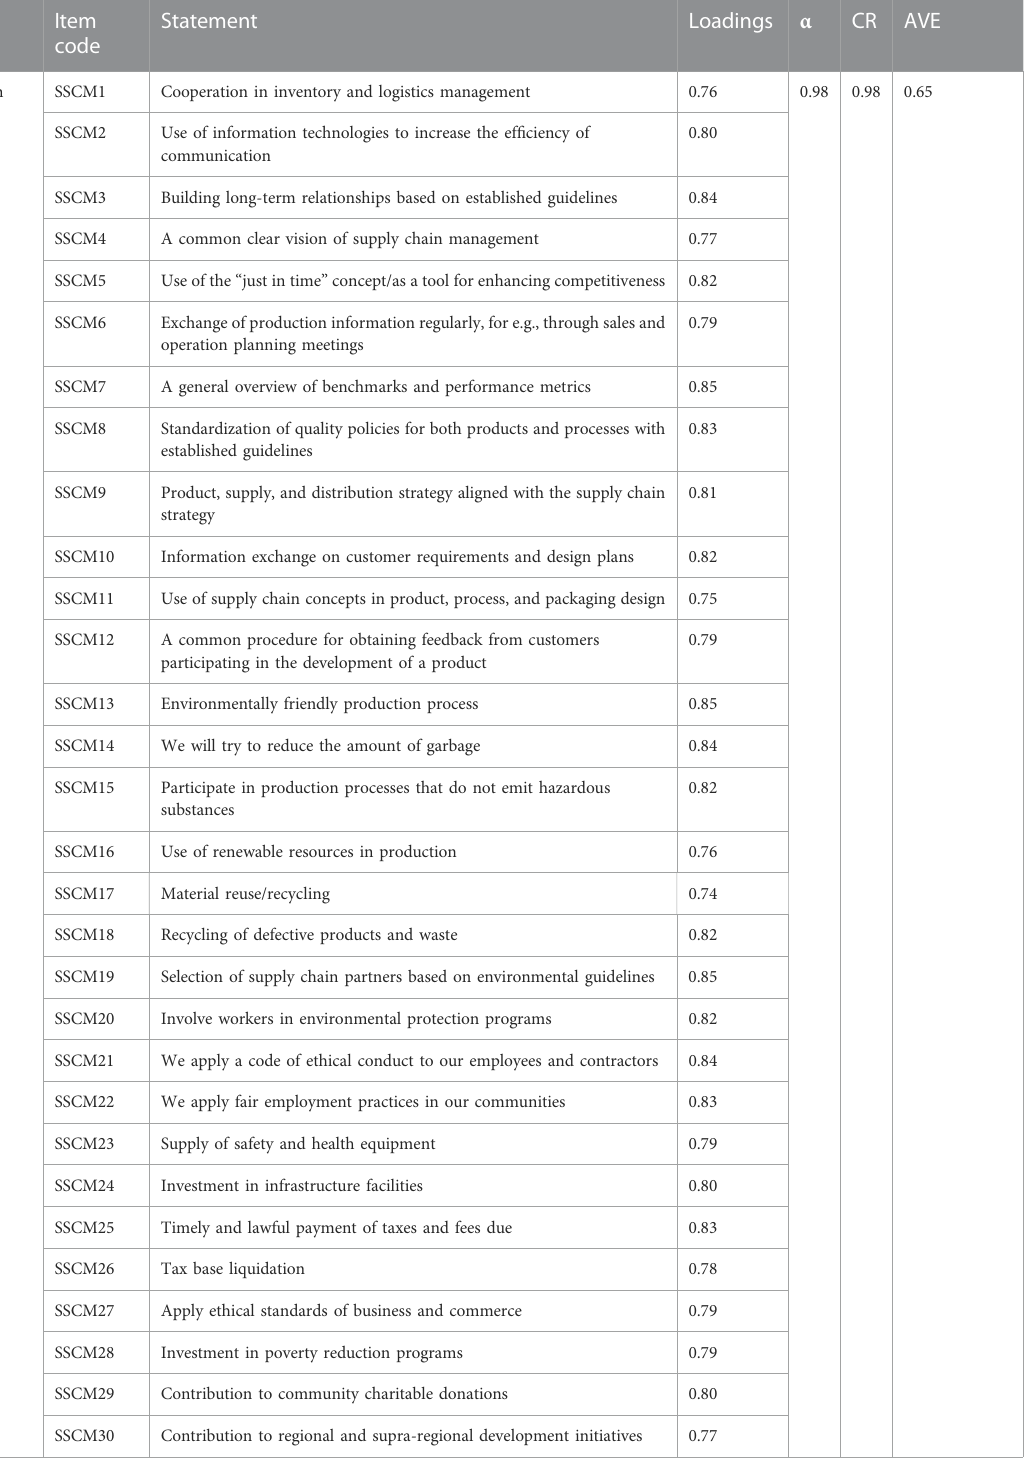
threshold of 0.85. As a result, the discernment greatly improves con fi dence. Table 3 shows the values per the established